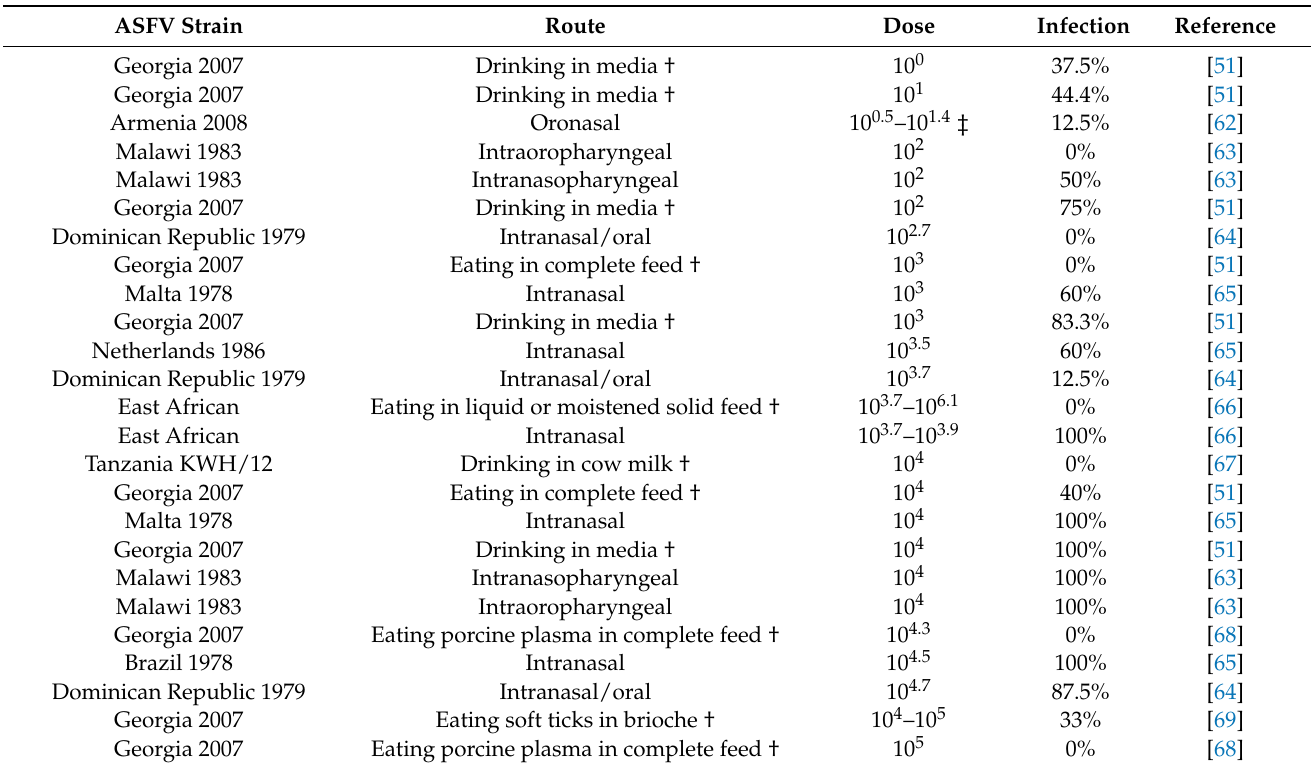
Table 1. Infection rates of different doses and strains of African swine fever virus (ASFV) when administered through the oronasal route or consumed through natural eating and drinking behaviors